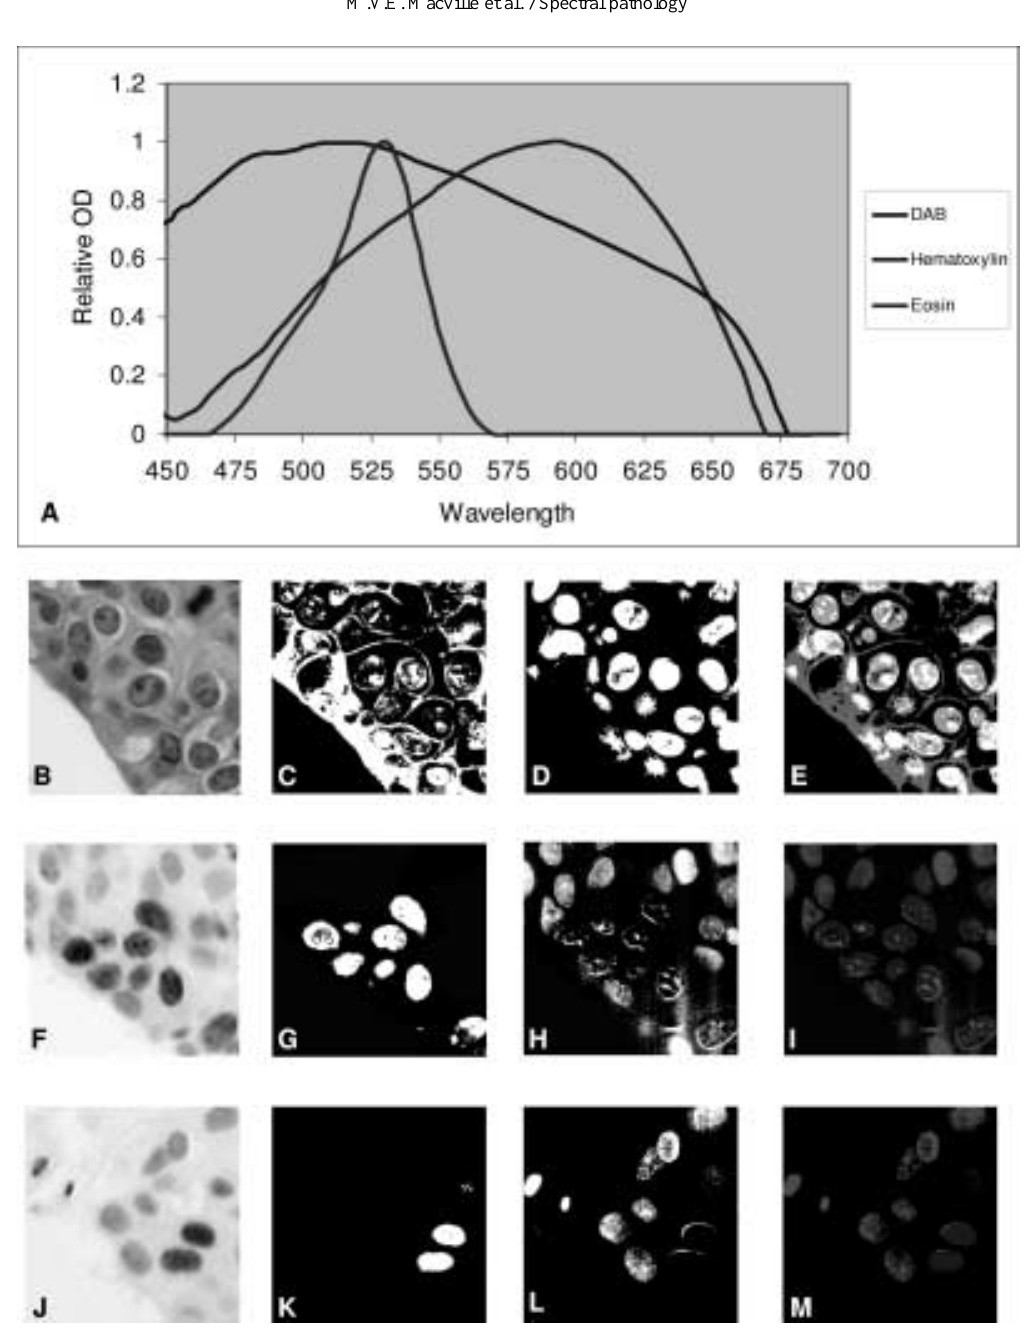
Fig. 5. (A) Chart of DAB, hematoxylin, and eosin pure dye absorption spectra used in ICC experiment on AgarCyto of a cervical scraping from a woman diagnosed with severe dysplasia, expressed in relative optical density (OD) for all wavelengths between 450 and 700 nm. Spectral classification of HE stained paraffin section (B–E) showing the raw microscopic image (B), separate eosin- (C) and hematoxylin- (D) detection in gray-scale images, and merged into an RGB false color image (E). Eosin is shown in purple and found predominantly in the cytoplasm but also in the nucleus. Hematoxylin is shown in green and only found in the nucleus. Pixels in which both eosin and hematoxylin have been detected are shown in white. Spectral analysis of immunodetection for Ki-67 (F–I) and TP53 (J–M). The raw microscope images (F, J) show the brown DAB precipitate for immunopositive nuclei and the blue hematoxylin for immunonegative nuclei. Pixel-by-pixel spectral decomposition resulted in the DAB detection images (G, K), hematoxylin detection images (H, L), and the merged images in RGB pseudo-colors, showing DAB immunopositive nuclei in blue and immunonegative nuclei in red (I,